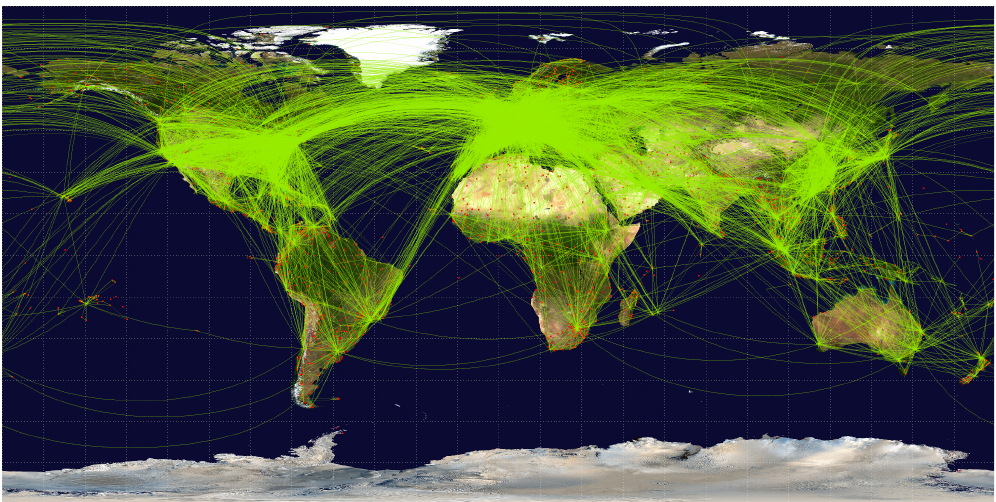
Figure 23. Global flight network (source: Wikimedia Commons, https://commons.wikimedia.org/ wiki/File:World-airline-routemap-2009.png).